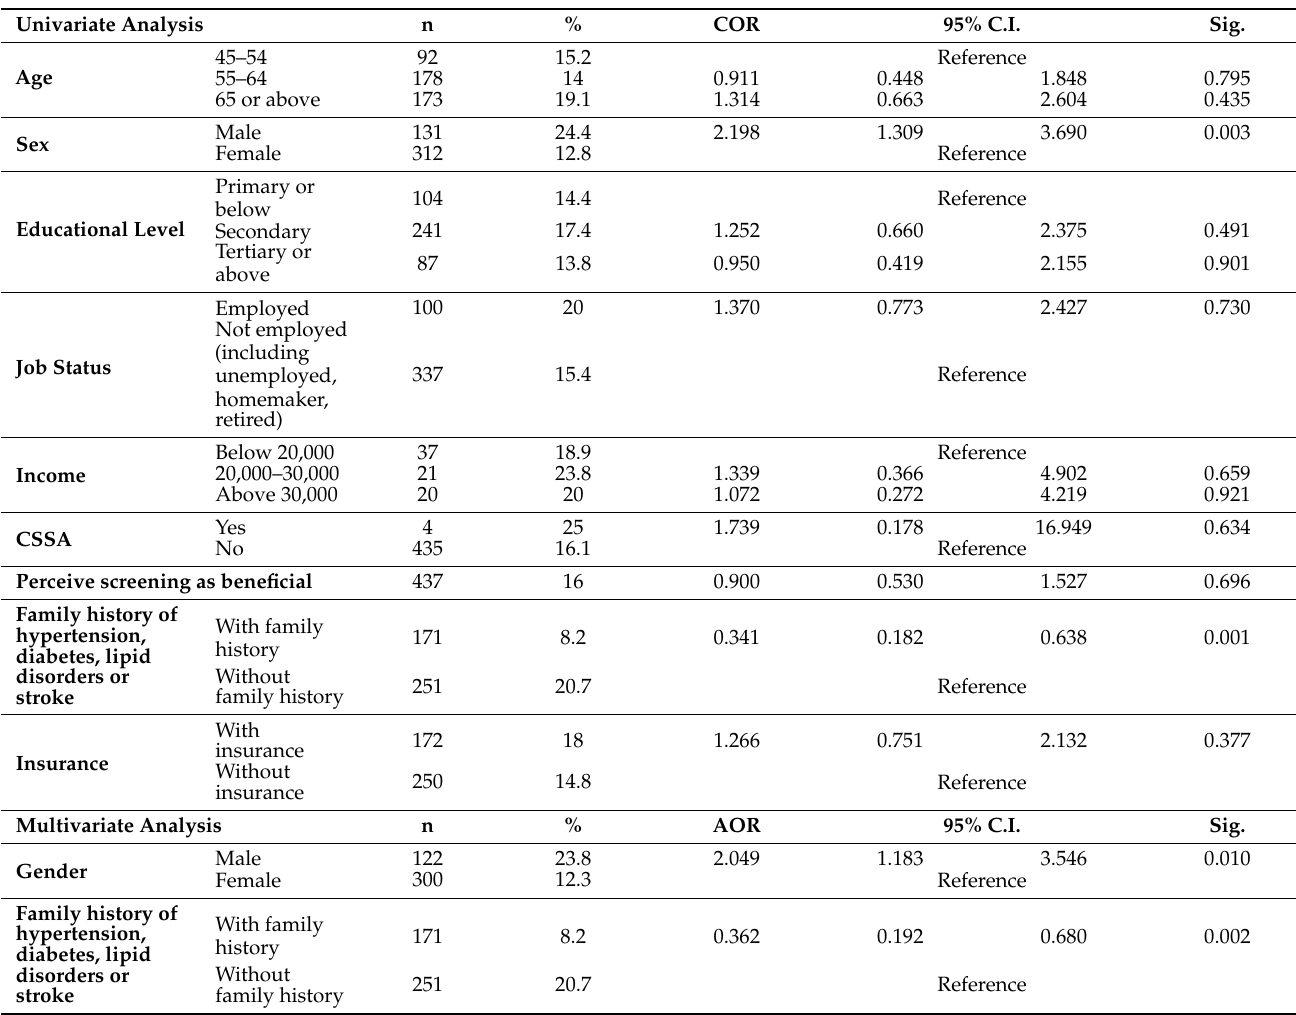
Table 5. Factors associated with unwillingness participate in voucher scheme for